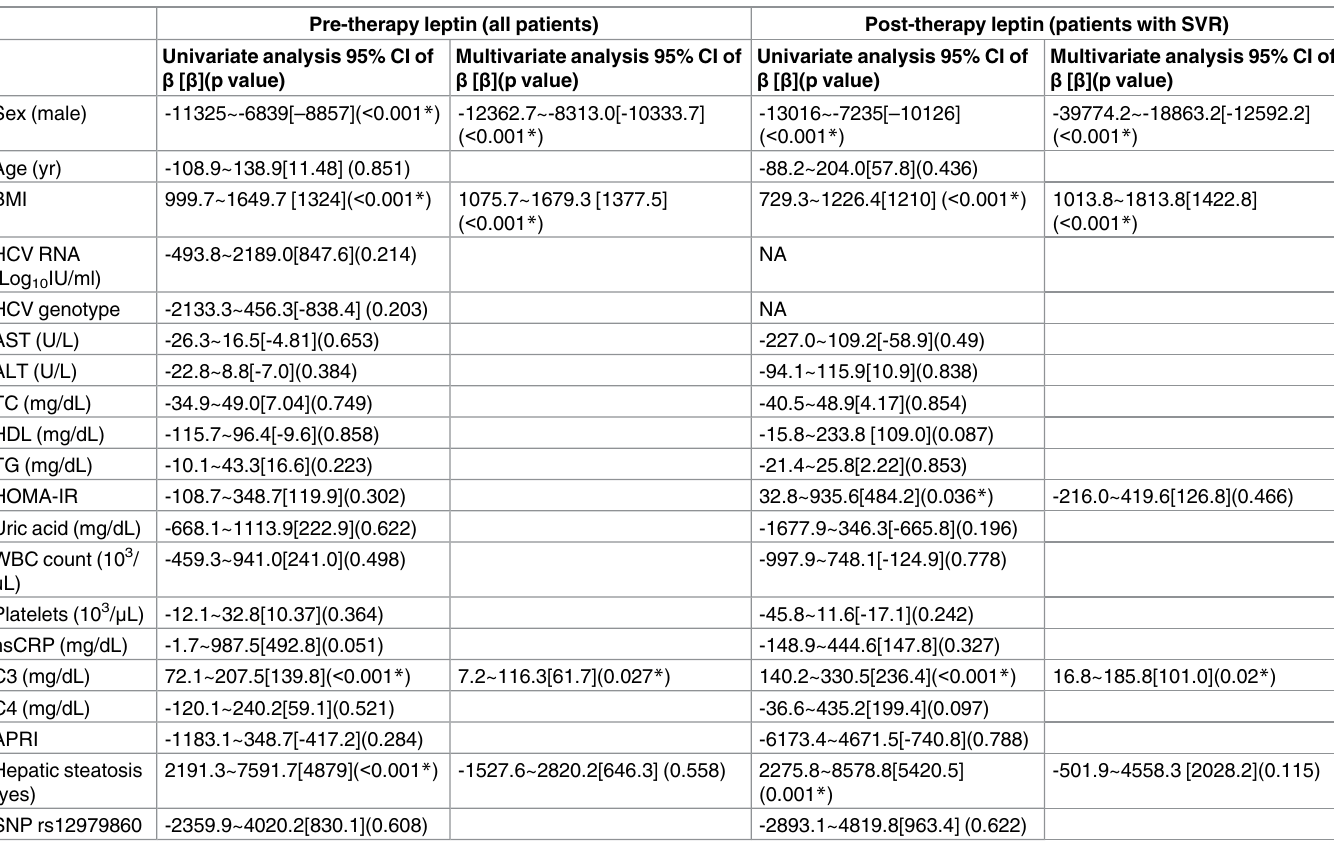
Table 2. Univariate and multivariate analysesof factors associated with pre- and post-therapy leptin levels. Pre-therapy leptin (all